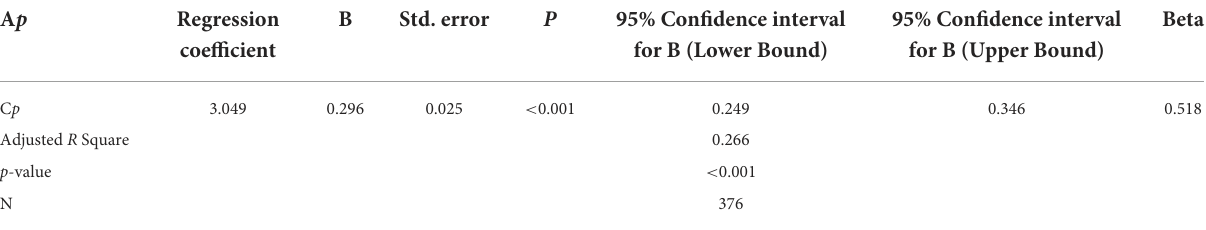
TABLE 6 Correlation and regression analysis for the self-reported comprehensive ability of graduate clinical medical students providing TCC. A